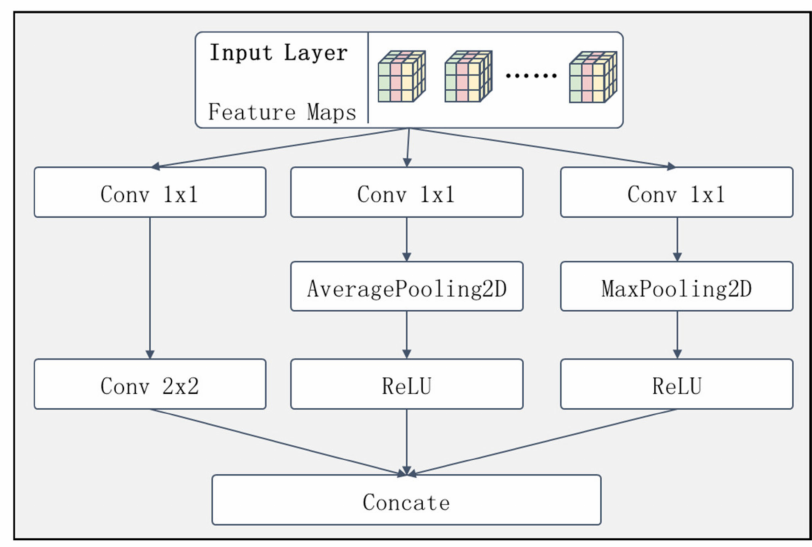
Figure 13. Maximum and Average feature extraction module.